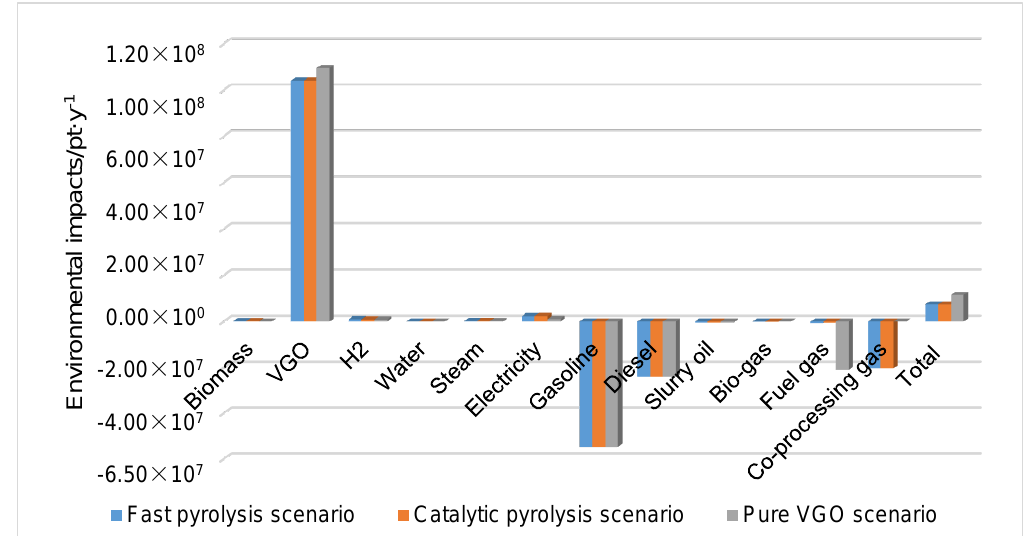
Figure 6. Environmental impacts of the three scenarios in Case 2.